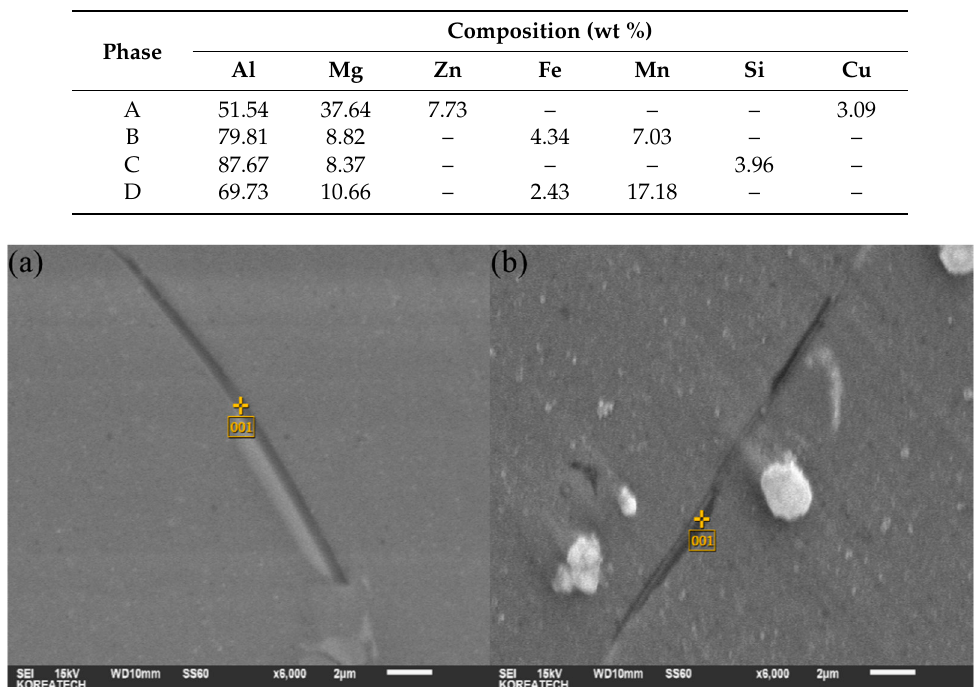
Figure 6. SEM-EDS mapping of secondary phases before homogenization. Table 3. Chemical composition of secondary phases in Figure 6 before homogenization.